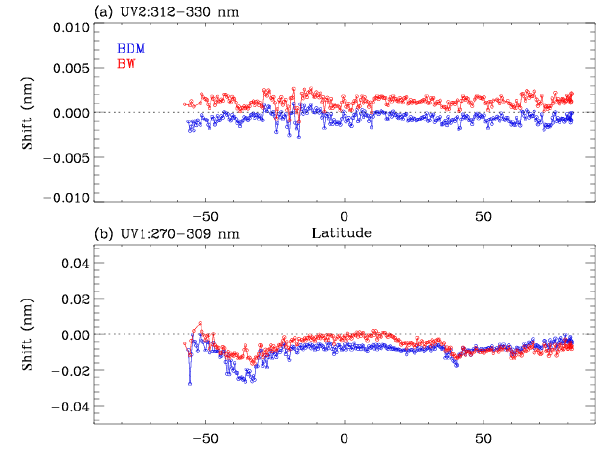
Figure 8. Comparison of the wavelength shifts (nm) between ozone cross-sections and OMI radiances at the nadir view for using BDM (blue) and BW cross-sections,